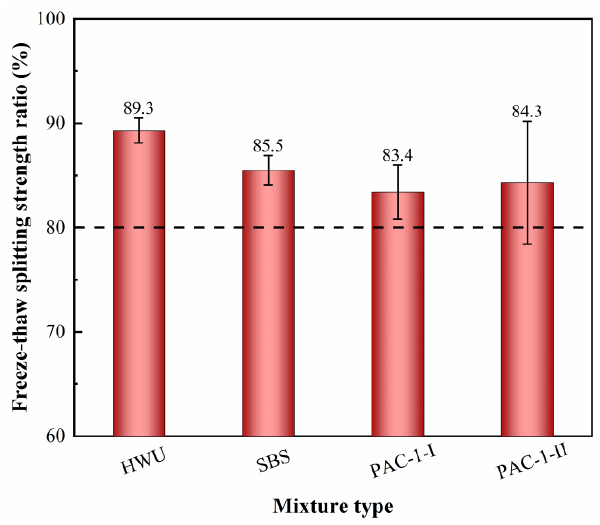
Figure 9. Freeze – thaw splitting tensile strength ratio results of the mixtures. Figure 9. Freeze–thaw splitting tensile strength ratio results of the